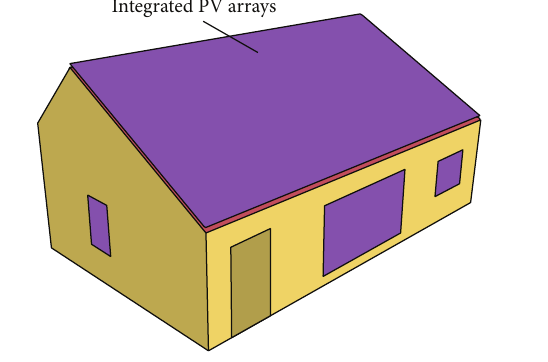
Figure 2: Model of the BIPV house. Figure 3: Temperature measurement points for the regular house when it was not exposed to